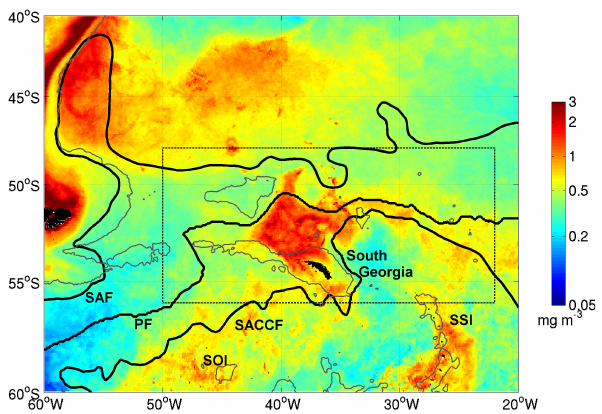
Fig. 1. Austral summer (January–February) chlorophyll a clima- tology derived from MODIS for the 2003–2012 time period in the southwestern sector of the Atlantic Southern Ocean. Bold lines indi- cate the Subantarctic Front (SAF, Orsi et al., 1995), the Polar Front (PF, Moore et al., 1999) and the Southern ACC Front (SACCF, Thorpe et al., 2002). The position of the South Orkney Islands (SOI) and the South Sandwich Islands (SSI) are also indicated. The rect- angle indicates the South Georgia area referred to in the text.